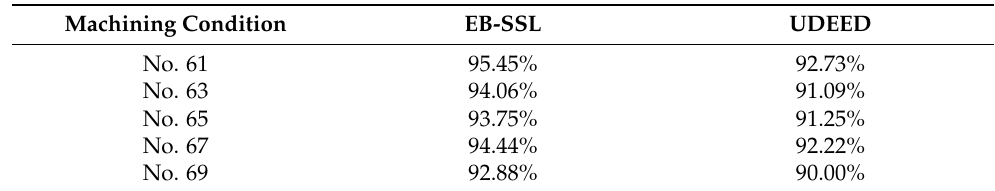
Table 5. Recognition results of different